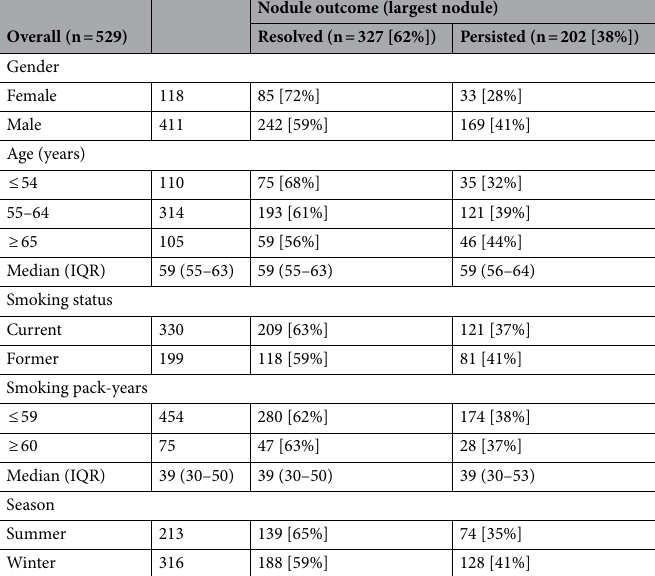
Nodule Level (n = 820) Participant Level (n =